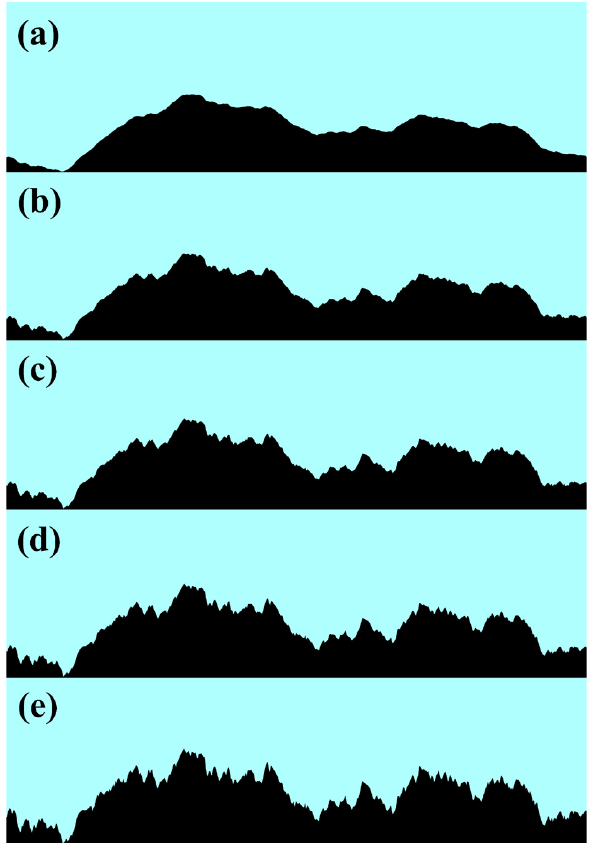
Figure 9. Similar solid walls with different fractal dimensions: ( a ) D = 1.03476, ( b ) D = 1.06289, ( c ) D = 1.08107, ( d ) D = 1.10391, and ( e ) D =